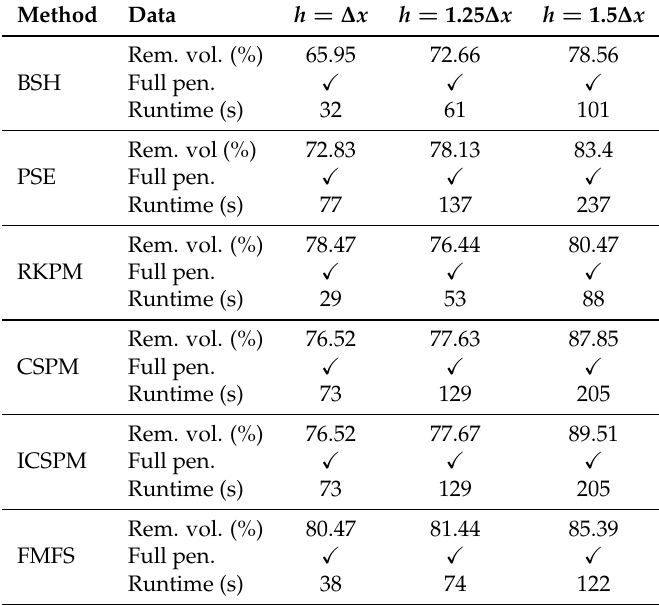
Table 4. Batch 2: Coarse discretization using a total of 27k particles with the Wendland quintic kernel.